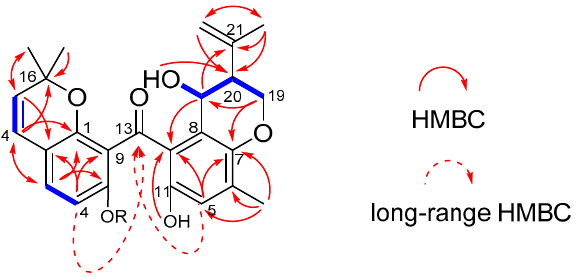
Figure 2. COSY (heavy blue lines) and selected HMBC (red arrows) correlations for 1 and/or 2 .